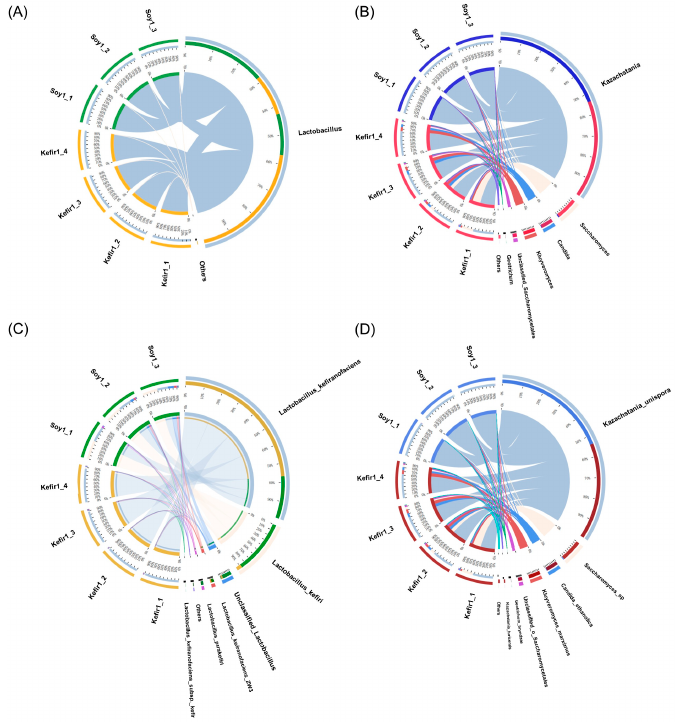
Figure 4. Circos diagram of bacterial ( A ) and fungal ( B ) communities at the genus level, and bacterial ( C ) and fungal ( D ) communities at the species level.